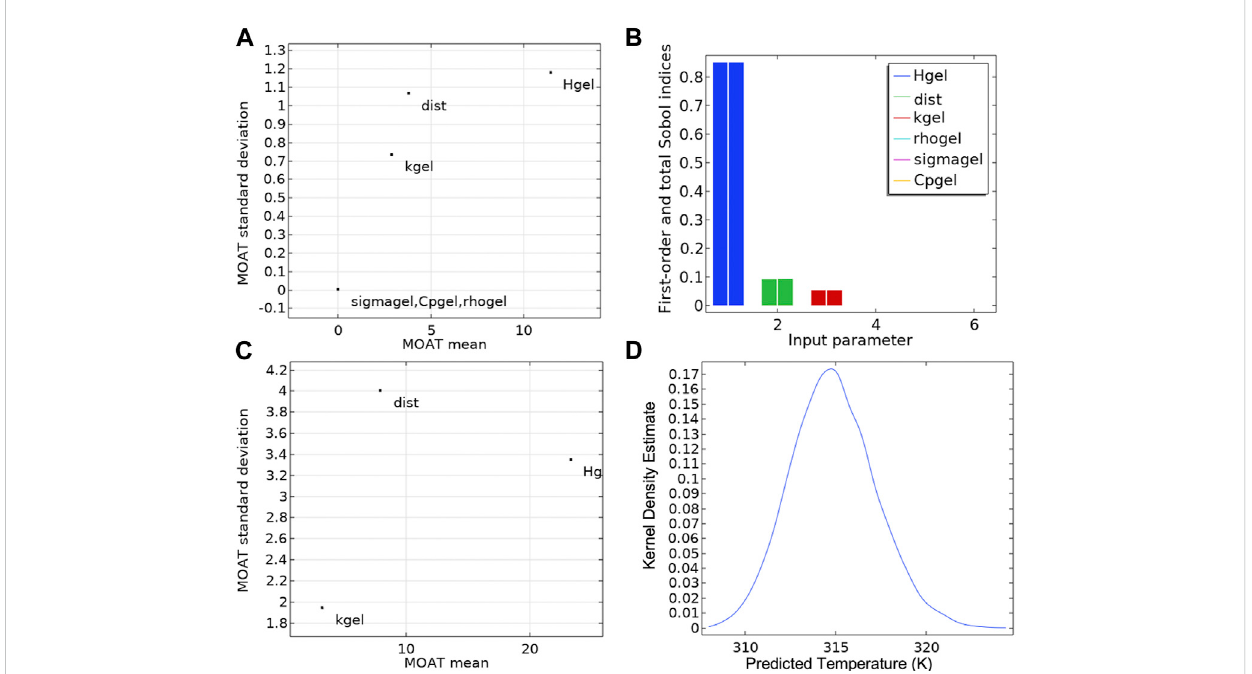
FIGURE 4 Sensitivity analysis and uncertainty propagation. (A) The Morris one-at-a-time (MOAT)method was applied to each input parameter in fl uencing the probe temperature at steady state ( t = 30 min), in the gel + Cu wire experimental setup shown in Figure 1. (B) Sensitivity analysis using the Sobol and correlation methods. The fi rst order Sobol index is depicted as the left bar for each parameter in the histogram plot. The total Sobol index, right bar for each parameter in the histogram plot, shows the variance of the probe temperature attributed to the variance of each input parameters and its interactionwiththeotherinputparameters. (C) TheMOATanalysiswithhigheruncertainty(±10%)ininputsAMFamplitude( H gel )andprobedistancefrom Cu surface ( dist ). (D) Kernel density estimation of the probability distribution function (PDF) of the probe temperature at 1.3 mm from Cu heat source, measuredafter10 minofheating.Uncertainties inAMFamplitudeandprobedistancefromthehighheatingCusourcecanresultinsigni fi cantvariancein the measured temperature at the probe